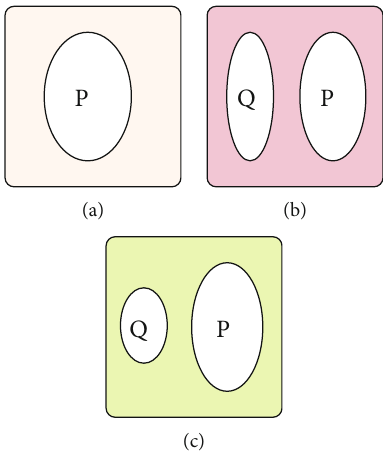
Figure 3: (a) Monitored, (b) unmonitored, and (c) semimonitored.